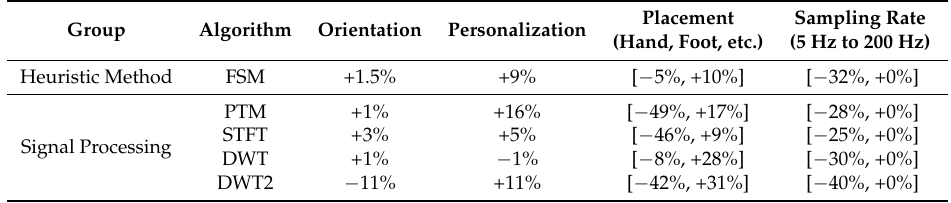
Table 9. SC accuracy under various contexts (FPR ≈